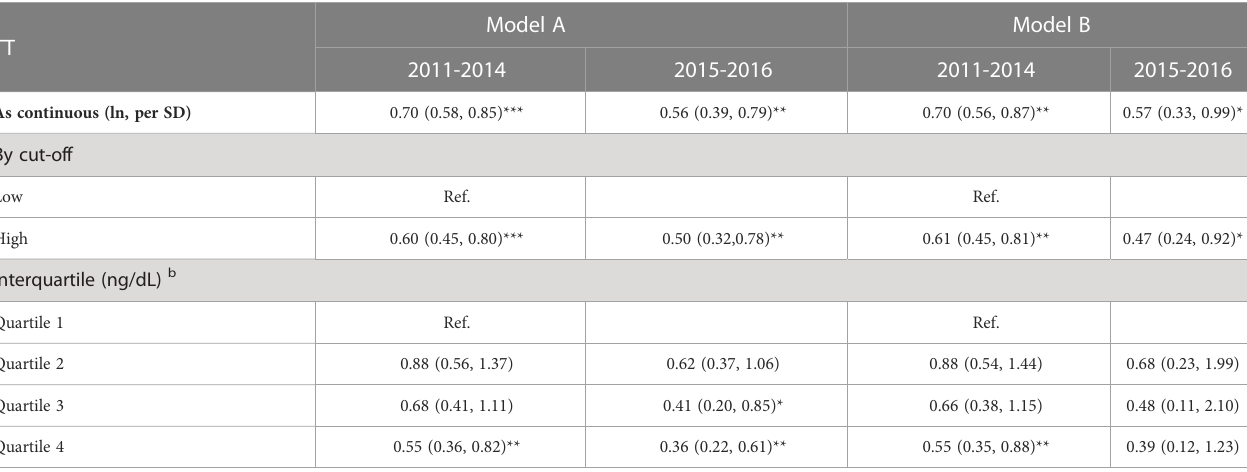
TABLE 2 The association between TT and MetS in women a .